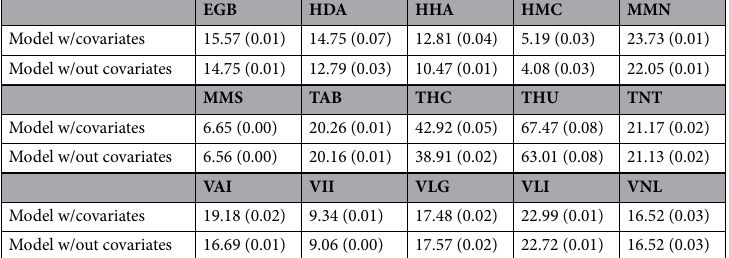
Fig. 1. As described in “Statistical model”, the proposed framework is based on a Bayesian model that can sample and estimate unknown parameters including ˆ Y i ( T it ) , the estimate of the unobserved true concentration value (see Eq. 3). ˆ Y i ( T it ) can be seen as posterior estimates of the true concentrations after removing noises incurred by various factors. In this manuscript, for simplicity, we designate the posterior estimates of the true concentrations ˆ Y i ( T it ) as the “posterior curves” generated from the proposed framework. For each site, the number of posterior curves is 2500, which corresponds to the number of MCMC iterations used for posterior inference. Figure 1 shows the distribution of posterior curves of ˆ Y i ( T it ) at the 15 sampling locations using the comprehensive model with two covariates [(sample storage temperature in degree Celsius ( ◦ C) and daily influent volume into the WWTP in megalitre (MI)], with color saturation representing the density of posterior curves. The two sampling sites at Halifax (HDA and HHA) do not report sampling results regularly, and the reported virus concentrations are very sparse for the two sites. However, thanks to the hierarchical structure of the proposed framework those sites borrow information from other sites; we can impute the “missing” concentrations, but the imputed poste- rior curves have a large variation and uncertainty, as shown in Fig. 1. The root mean squared errors (RMSE) of the posterior curves at each site for the model without covariates (i.e. P = 0 ) and the comprehensive model with two covariates are shown in Table 1. The RMSEs are calculated